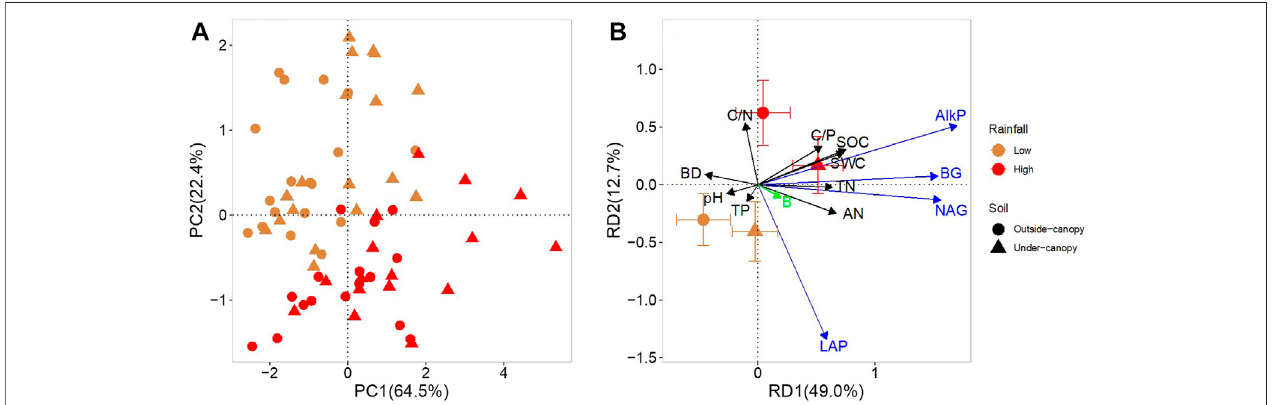
FIGURE 4 | (A) Biplot for distribution pattern of enzyme activities and (B) the relationships between the pattern of enzyme activities and the physicochemical or microbialproperties insoilunder(Under-canopy, fi lledtriangle)and outsidethecanopy(Outside-canopy, fi lledcircle)ofshrub species Artemisiagmelinii fromsitesoflow (brown) and high rainfall (red). Shown are soil physicochemical or microbial properties that signi fi cantly explained data variation of enzyme activities. Black and green arrows representsoilphysiochemicaland microbialproperties,respectively, andtheblue arrows represent enzymaticparameters. Percentages oftotal variationof data explained by the fi rst two axes are given in parentheses. BG, β -1,4-glucosidase (BG); NAG, β -1,4-N-acetylglucosaminidase; NAP, leucine aminopeptidase; and AlkP, alkaline